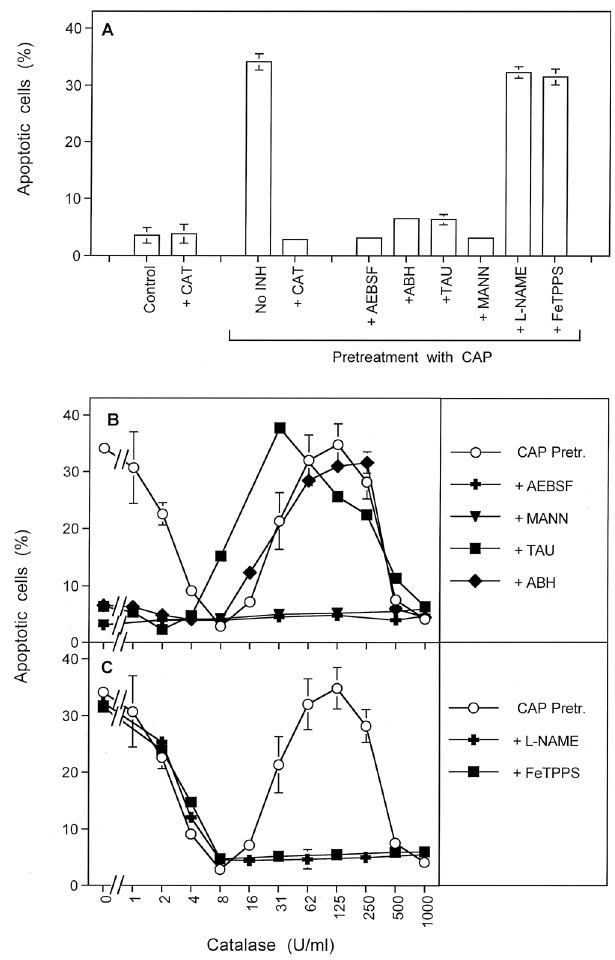
Figure 7. The relevance of catalase inactivation for apoptosis-inducing ROS/RNS signaling. ( A ) MKN-45 cells remained without pretreatment (control), received 8 U/ml exogenous catalase or were treated with CAP for 1 min, followed by 25 min of incubation and three cycles of washing. CAP-pretreated cells then remained either without inhibitors, or received 8 U/ml catalase, 100 µ M of the NOX1 inhibitor AEBSF, 150 µ M of the peroxidase inhibitor ABH, 50 mM of the HOCl scavenger taurine (TAU) or 25 µ M of the peroxynitrite (ONOO − ) decomposition catalyst FeTPPS. The determination of apoptotic cells after 3.5 h showed that apoptosis induction required treatment with CAP. The effect of CAP treatment was due to selective establishment of HOCl signaling and was completely inhibited by exogenous catalase. This allows to conclude on the functional role of catalase for the protection of tumor cells towards HOCl signaling. This is in line with catalase being the central target for CAP treatment. ( B , C ) MKN-45 cells were pretreated with CAP for 1 min, followed by 25 min incubation in the same medium and three cycles of washing steps. The cells remained without inhibitor or received the indicated inhibitors. All assays then received the indicated increasing concentrations of catalase and apoptosis induction was determined after 3.5 h. The result shows that CAP treatment reactivated specifically HOCl signaling, without initial contribution of ⋅ NO/ONOO − signaling. With increasing concentrations of catalase, first HOCl signaling was efficiently inhibited before ⋅ NO/ONOO − signaling was reactivated. Finally ⋅ NO/ONOO − signaling was inhibited by very high concentrations of exogenous catalase. Statistical analysis: A: Apoptosis induction after CAP treatment, as well as inhibition by all inhibitors except FeTPPS was highly significant (p < 0.001). B, C: Apoposis induction after CAP treatment and in the presence of 0–2, as well as 31–250 U/ml catalase was highly significant (p < 0.001). The inhibition by AEBSF and mannitol was highly significant at all catalase concentrations (p < 0.001). Inhibition by taurine and ABH in the low concentration range of catalase (0–2 U/ml), and by L-NAME and FeTPPS in the high concentration range (31–250 U/ml) was highly significant (p < 0.001). The shifting effect of taurine in the concentration range of 16 and 31 U/ml was highly significant (p <